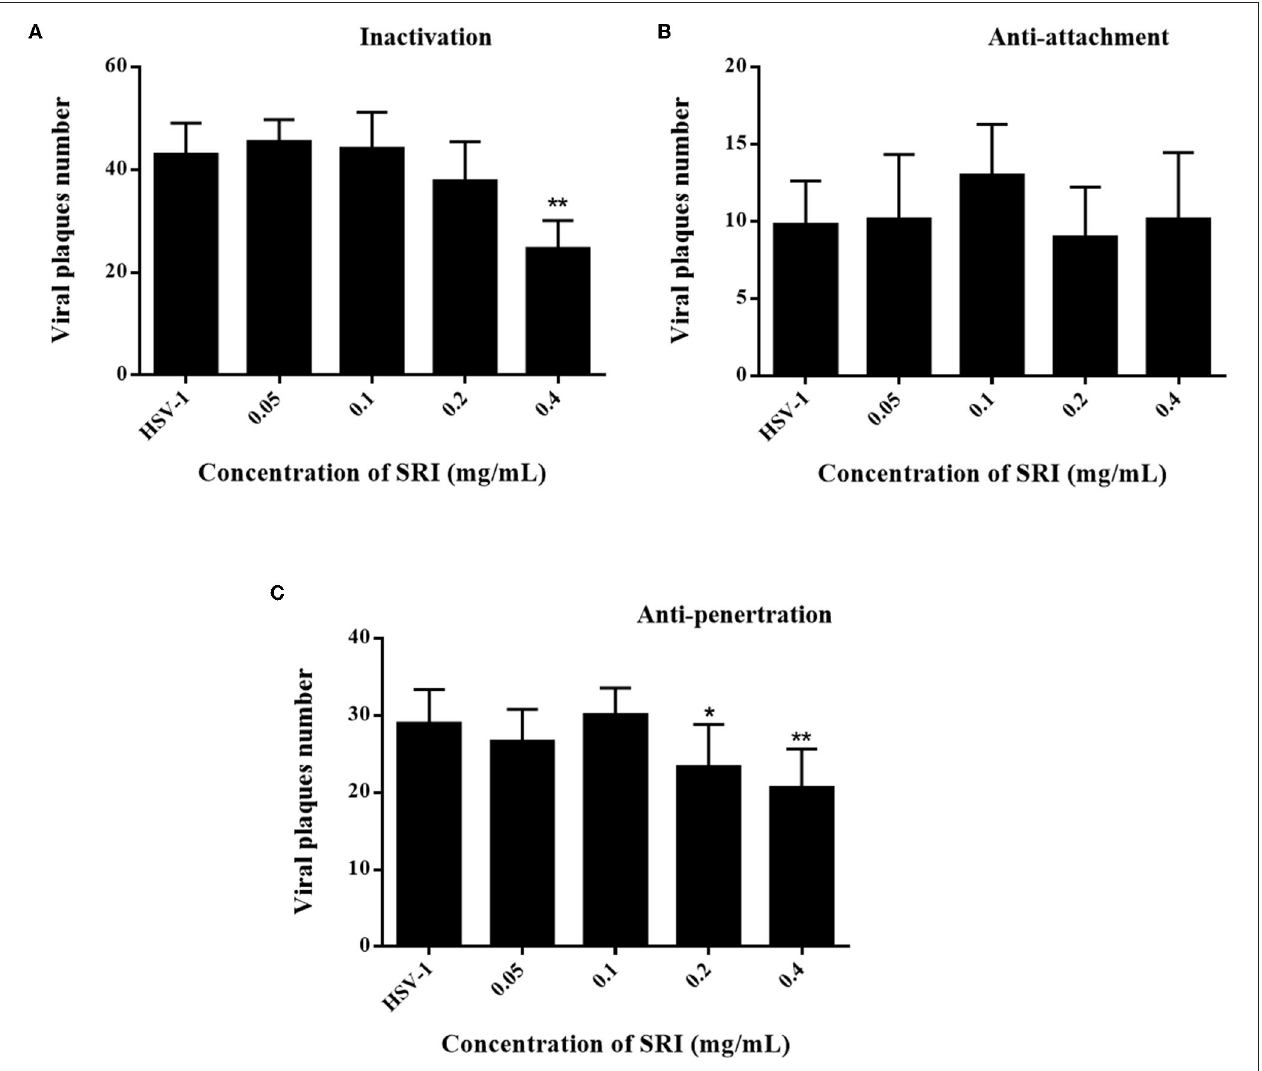
FIGURE 2 | Effects of different treatment conditions of SRI on HSV-1 infection. (A) Pre-treatment of virus: HSV-1 was pre-treated with SRI (0.05, 0.1, 0.2, and 0.4 mg/mL) and incubated at 37 ◦ C for 1h. The viral inoculum was added to a Vero cell monolayer and incubated for 2h. Then, a plaque reduction assay was performed to calculate the number of plaques. (B) Viral attachment: pre-chilled monolayer of Vero cells was infected with HVS-1 and SRI (0.05, 0.1, 0.2, and 0.4 mg/mL) and incubated for 2h at 4 ◦ C to allow binding (but not cellular uptake). Then, a plaque reduction assay was performed to calculate the number of plaques. (C) Viral penetration: HSV-1 was added to a pre-chilled monolayer of Vero cells. After incubation at 4 ◦ C for 2h, the viruses were removed and Vero cells were incubated with SRI (0.05, 0.1, 0.2, and 0.4 mg/mL) at 37 ◦ C for 2h to facilitate viral penetration. Then plaque reduction assay was performed to calculate the number of plaques. The results are presented as mean ± SD. * p < 0.05, ** p < 0.01 vs. HSV-1 group.